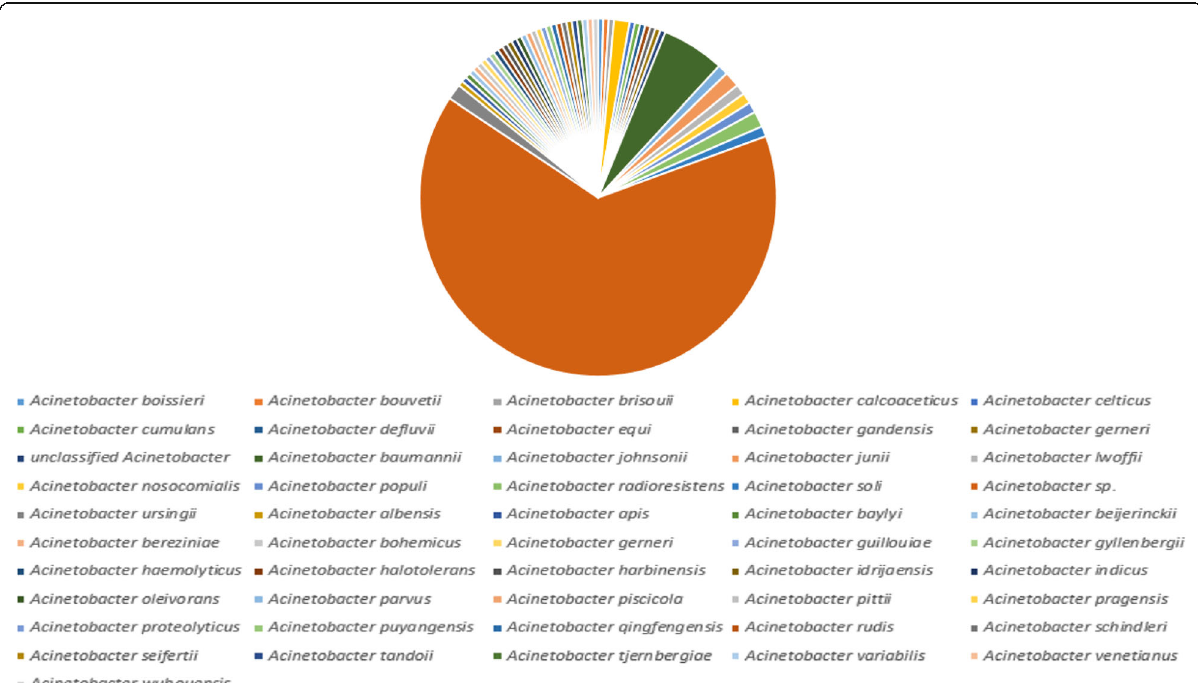
Fig. 3 Similarity pie diagram of MurB from A . baumannii and its related sequences from various Acinetobacter species obtained from iterative BLAST